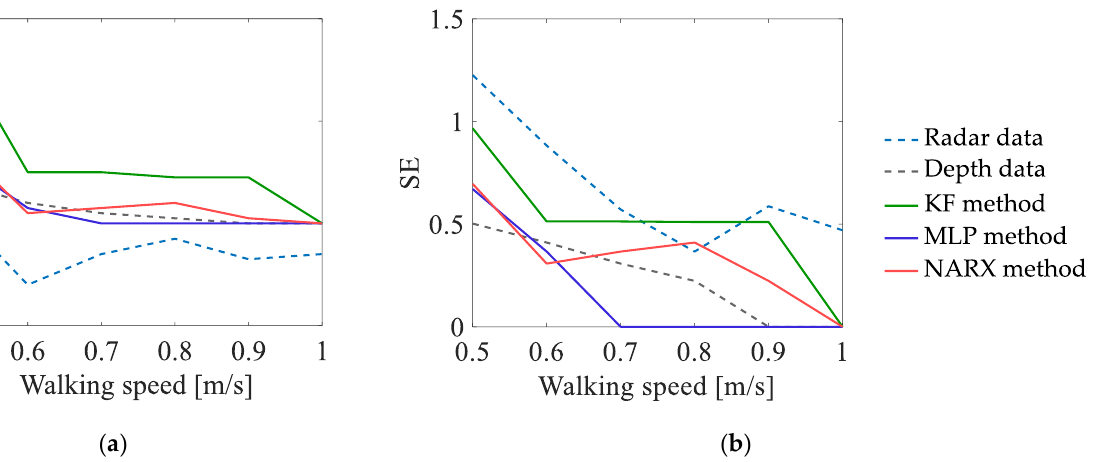
Figure 10. Uncertainty indicators characterising the estimates of the numbers of turns, obtained in EXP#2.